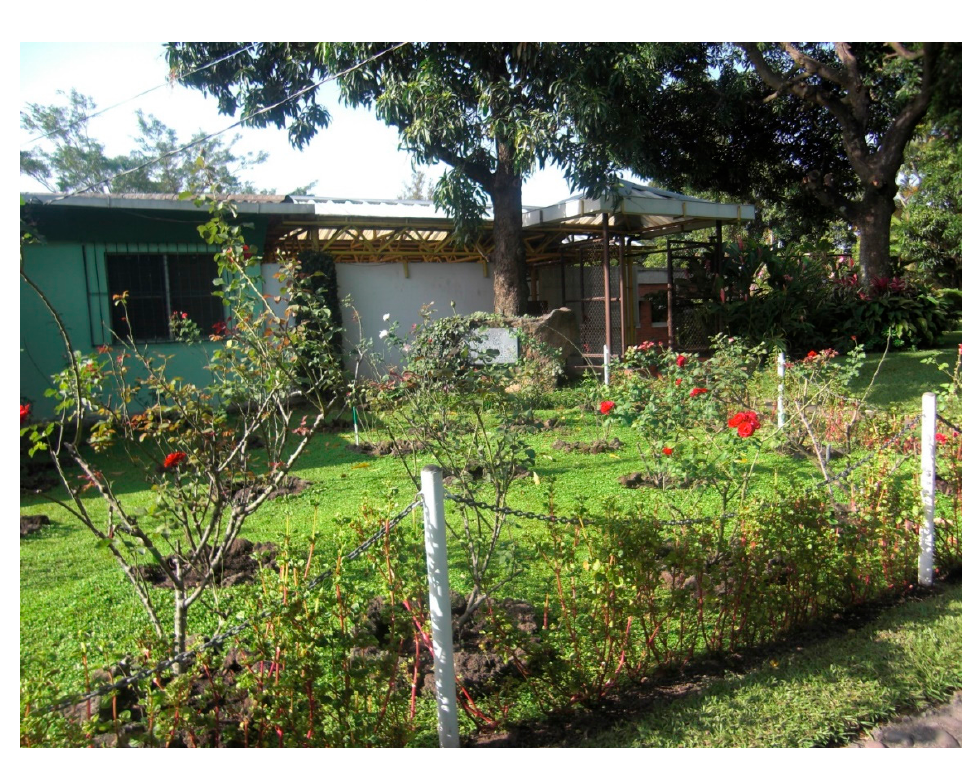
Figure 1. Garden of the Roses. The place where the UCA martyrs were executed. Photograph by Laura Teresa Sánchez, 2016.